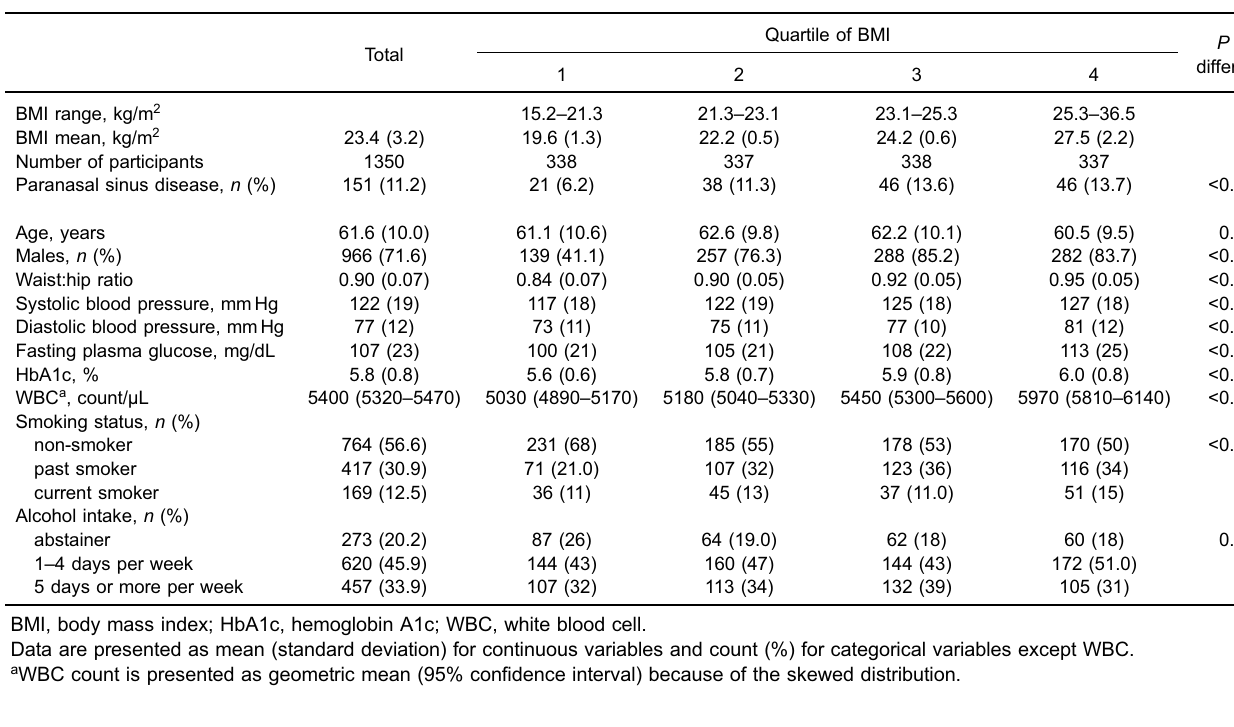
Table 1. Characteristics of study participants